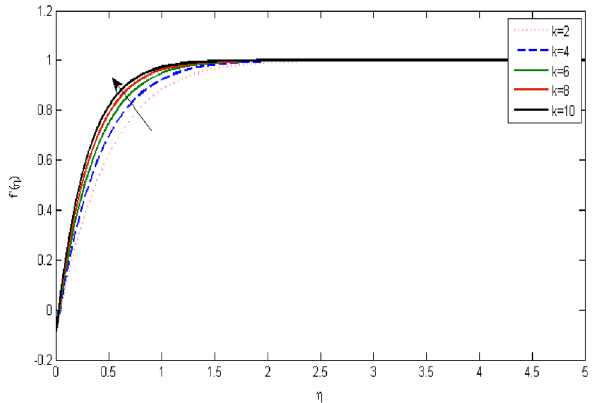
Figure 5. influence on f ′ .